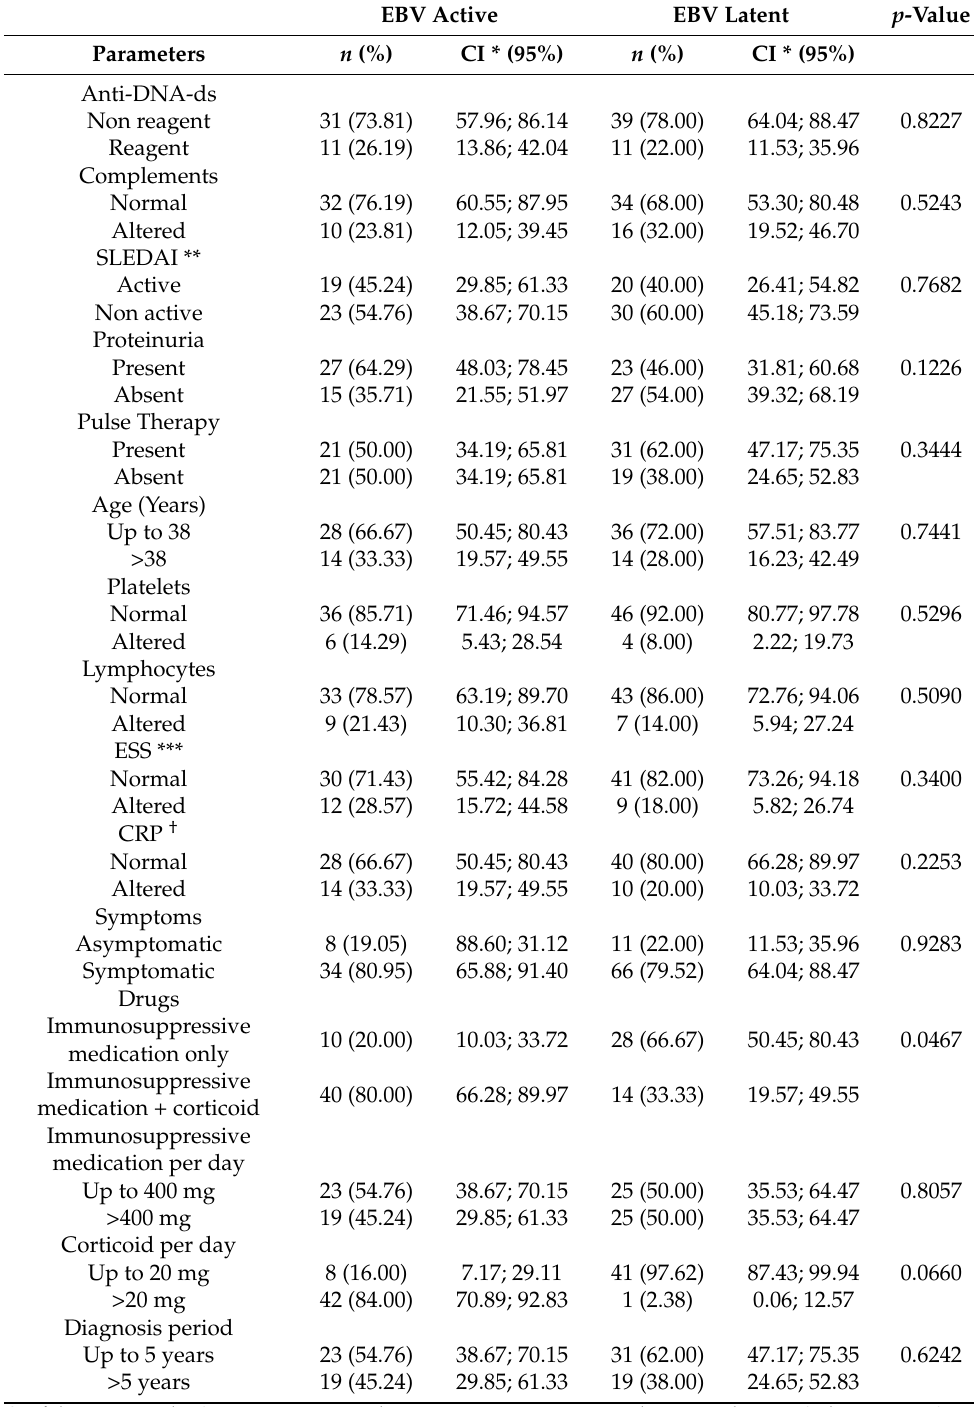
Table 4. Clinical, laboratory and therapeutic characteristics according to the profile of EBV infection in lupus patients ( n =